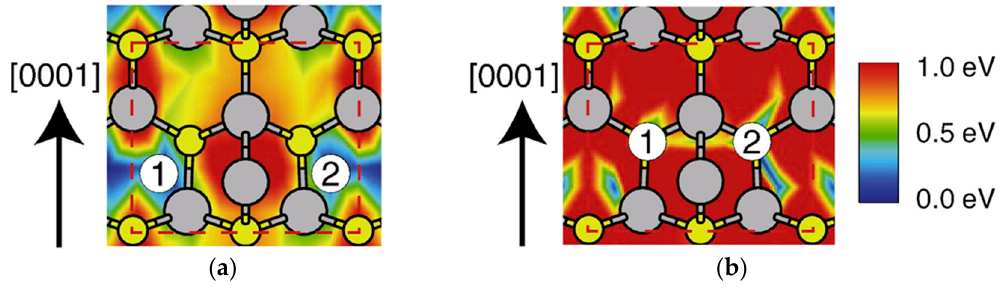
Figure 31. Calculated adsorption sites and migration barriers on the In-adsorbed ( 1100 ) surface for ( a ) In and ( b ) P atoms. Encircled numbers and contour plots represent adsorption sites and migration barriers, respectively. Large gray and small yellow circles represent In and P atoms, respectively. Reprinted with permission from [99]. Copyright (2013) by Elsevier.